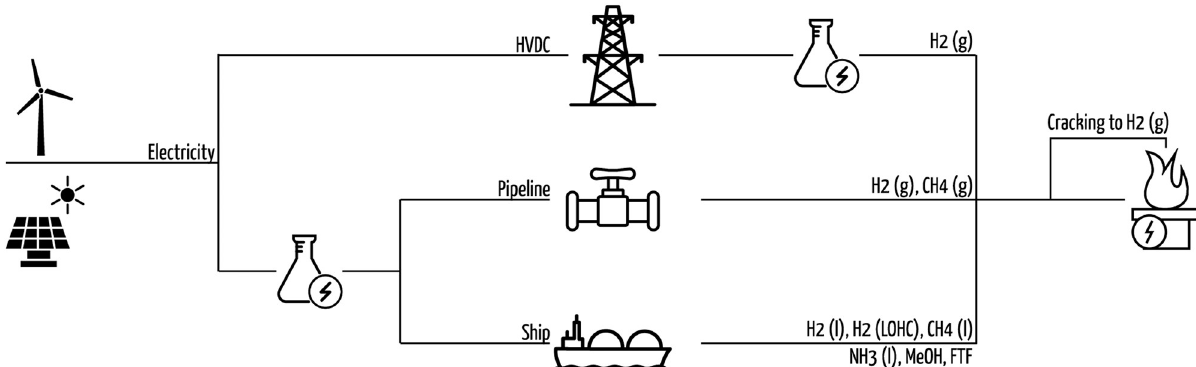
Fig 1. Schematic representation of ESCs considered in this study. ESCs cover electricity generation from RES, intermediary buffer storage for electricity and chemicals, conversion to chemical energy carriers, conditioning and transport from exporter to importer. Each ESCs delivers one out of five chemical energy carriers. Detailed representations of each ESC and all involved technologies are included in S1 Fig. License for icons: CC-BY-3.0 [17–21] and CC-0.